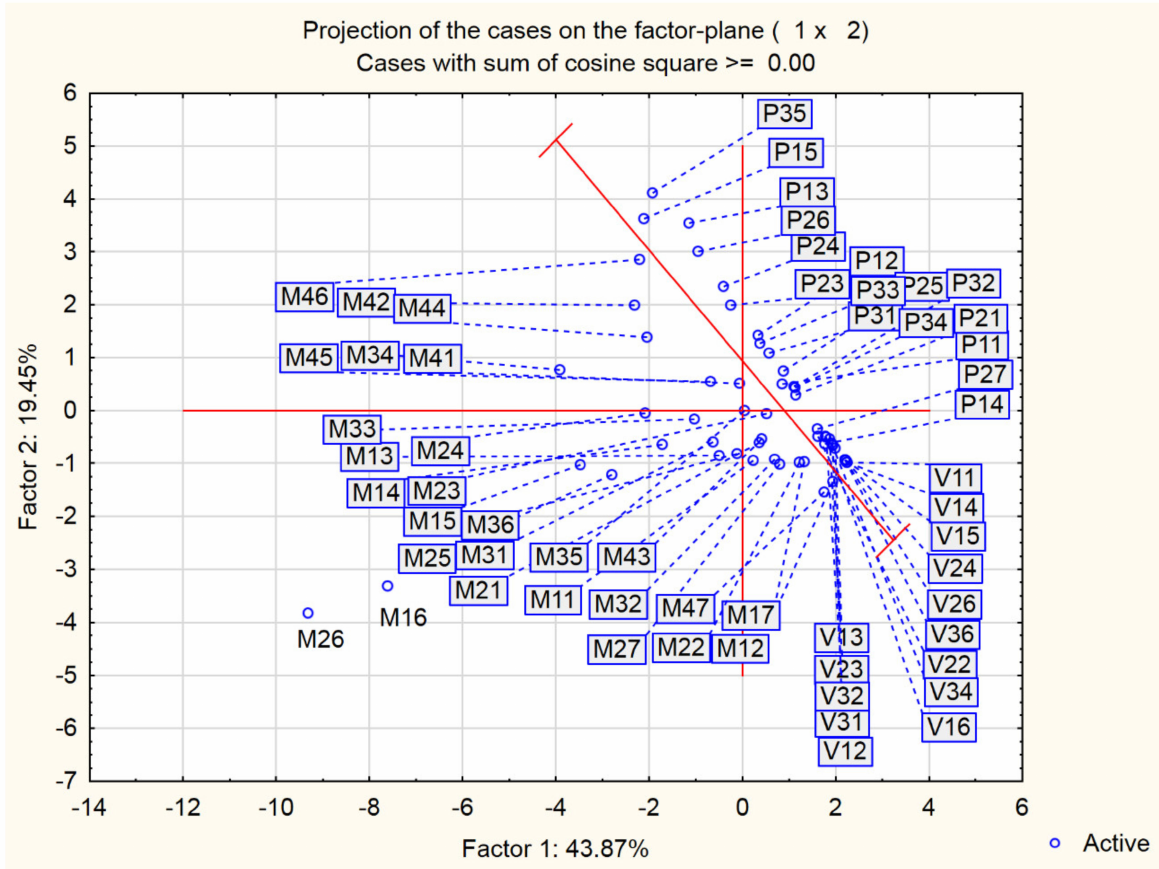
Figure 11. The score plot of the types of marine environments examined